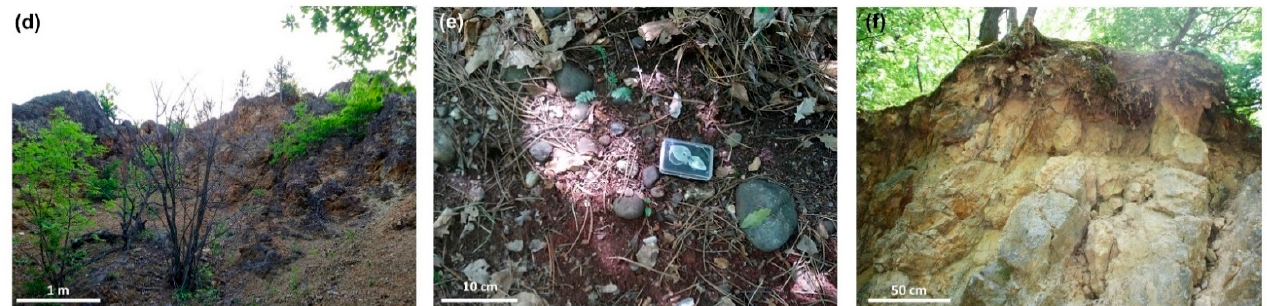
Figure 2. Geological units detailed in the text: ( a ) Unit A, in the Lojanik 1 area; ( b ) Unit B, at the Lojanik 1 Valley bottom, with an example of stream lateral erosion; ( c ) Unit C, in the Lojanik 3 area, close to LFS1; ( d ) Unit E, on the eastern slope of the Kremenjak Valley; ( e ) Unit F; ( f ) Bedrock outcrop, between Lojanik 2 and 3.